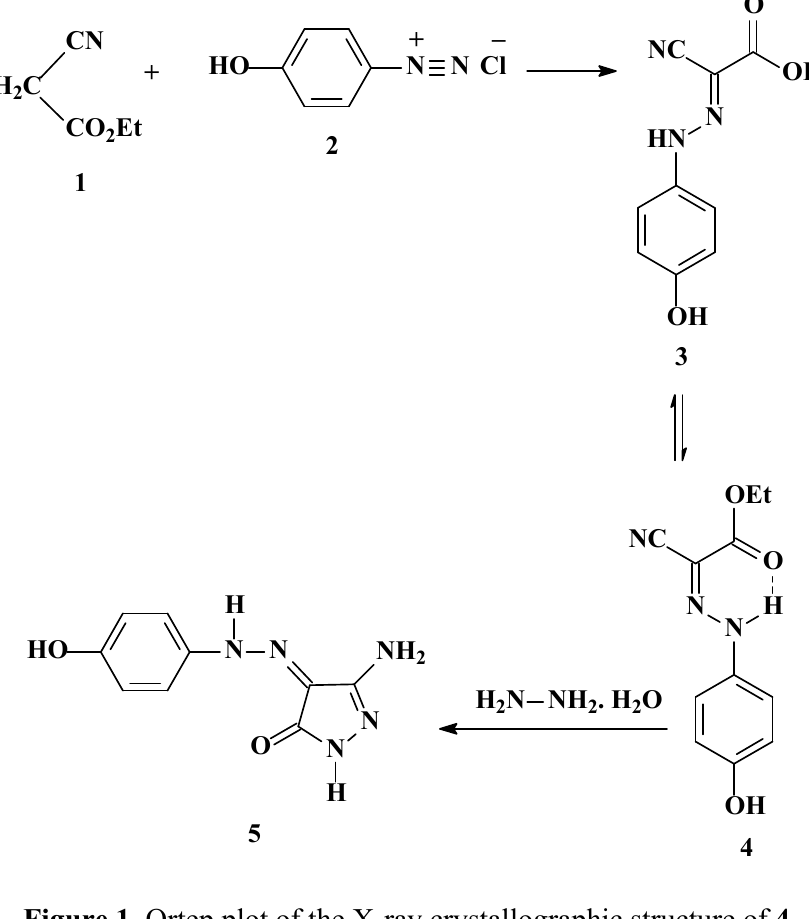
Figure 1. Ortep plot of the X-ray crystallographic structure of 4